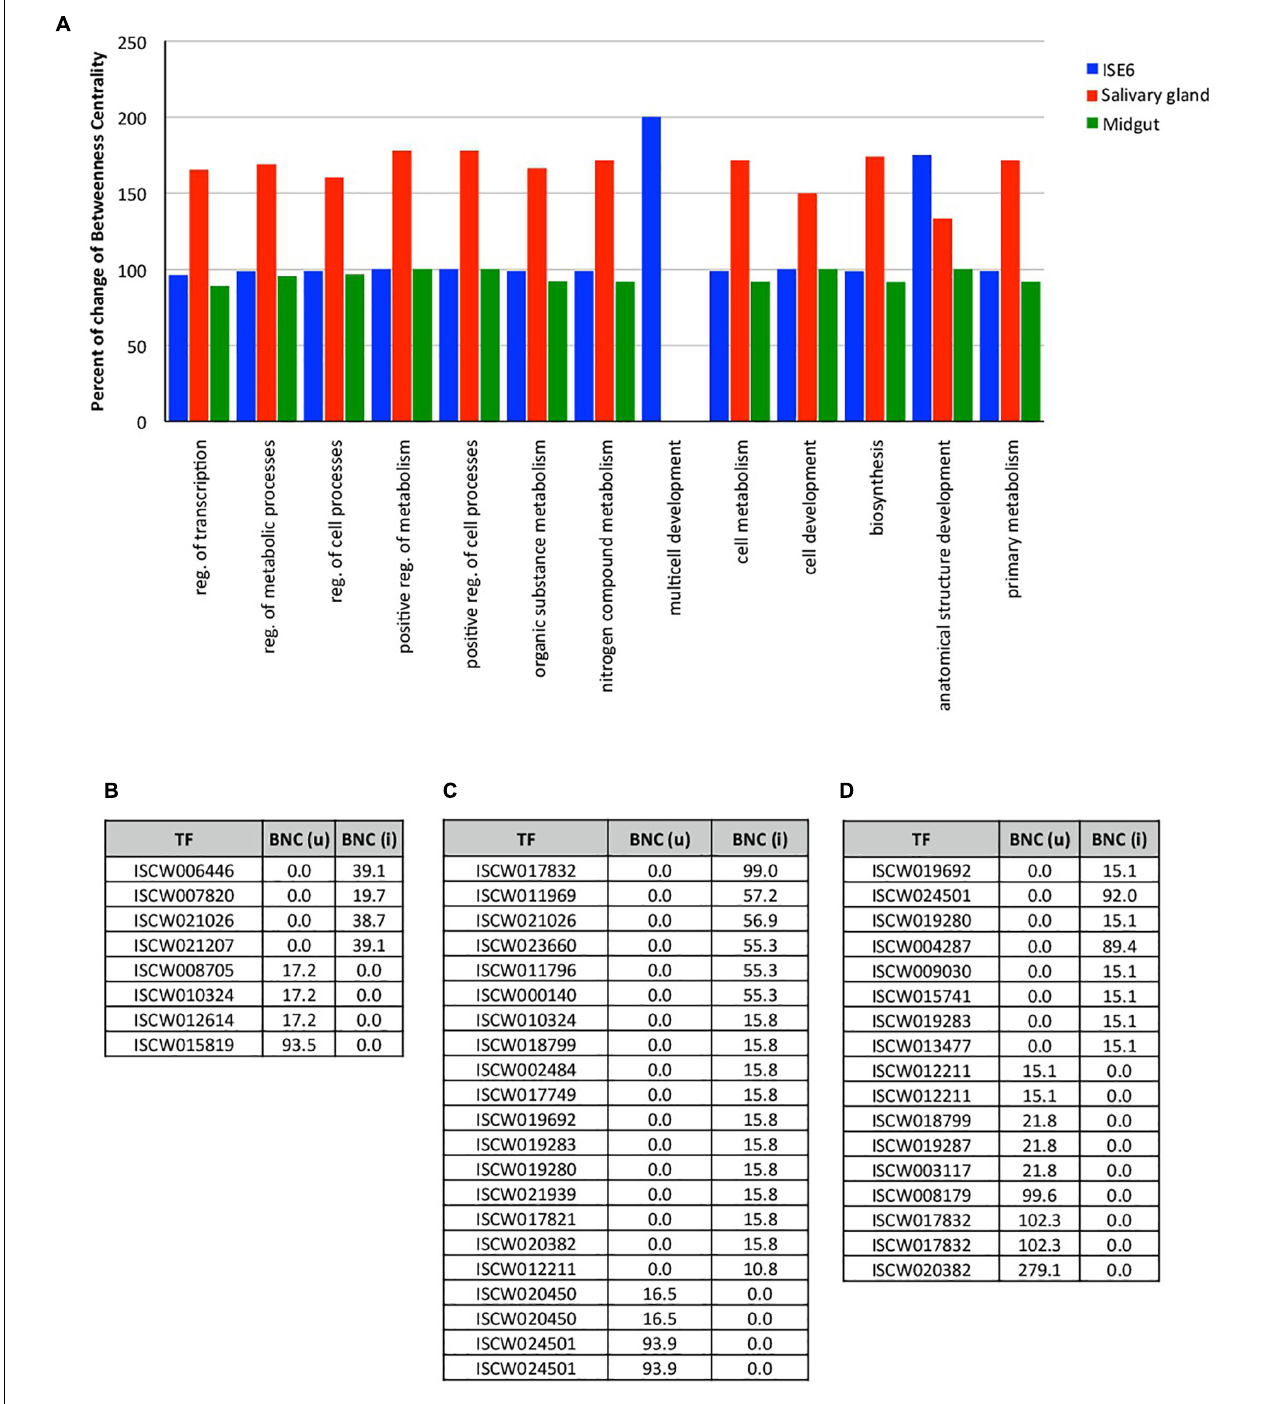
FIGURE 1 | Changes in the expression of TF in tick ISE6 cells, salivary gland and midgut in response to A. phagocytophilum infection. (A) The percentage change of the index Betweenness Centrality (BNC) infection among uninfected and infected target organs in the 13 BP GO annotations. (B) Values of BNC of the 8 TF that showed the highest changes between uninfected BNC (u) and infected BNC (i) ISE6 cells. (C) Values of BNC of the 21 TF that showed the highest changes between uninfected BNC (u) and infected BNC (i) salivary glands. (D) Values of BNC of the 17 TF that showed the highest changes between uninfected BNC (u) and infected BNC (i) midgut. Abbreviations: reg., regulation; (u), uninfected; (i), infected.